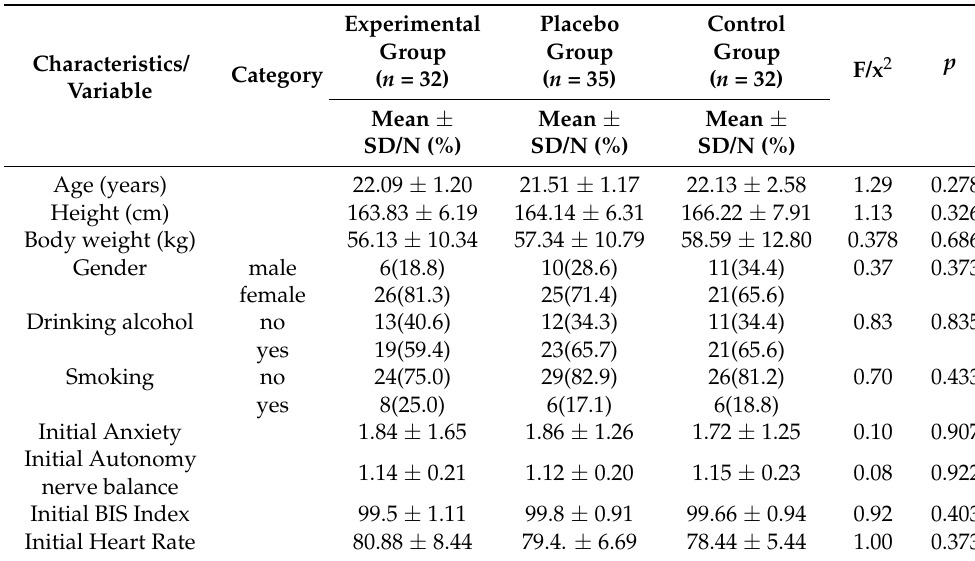
Table 1. Characteristics of the experimental, placebo, and control